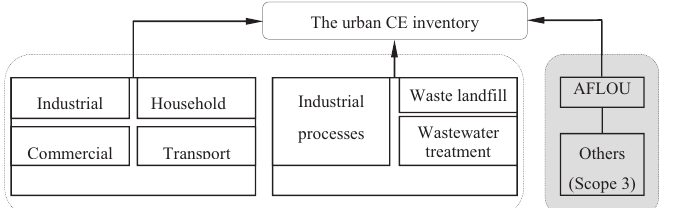
Figure 1. Accounting